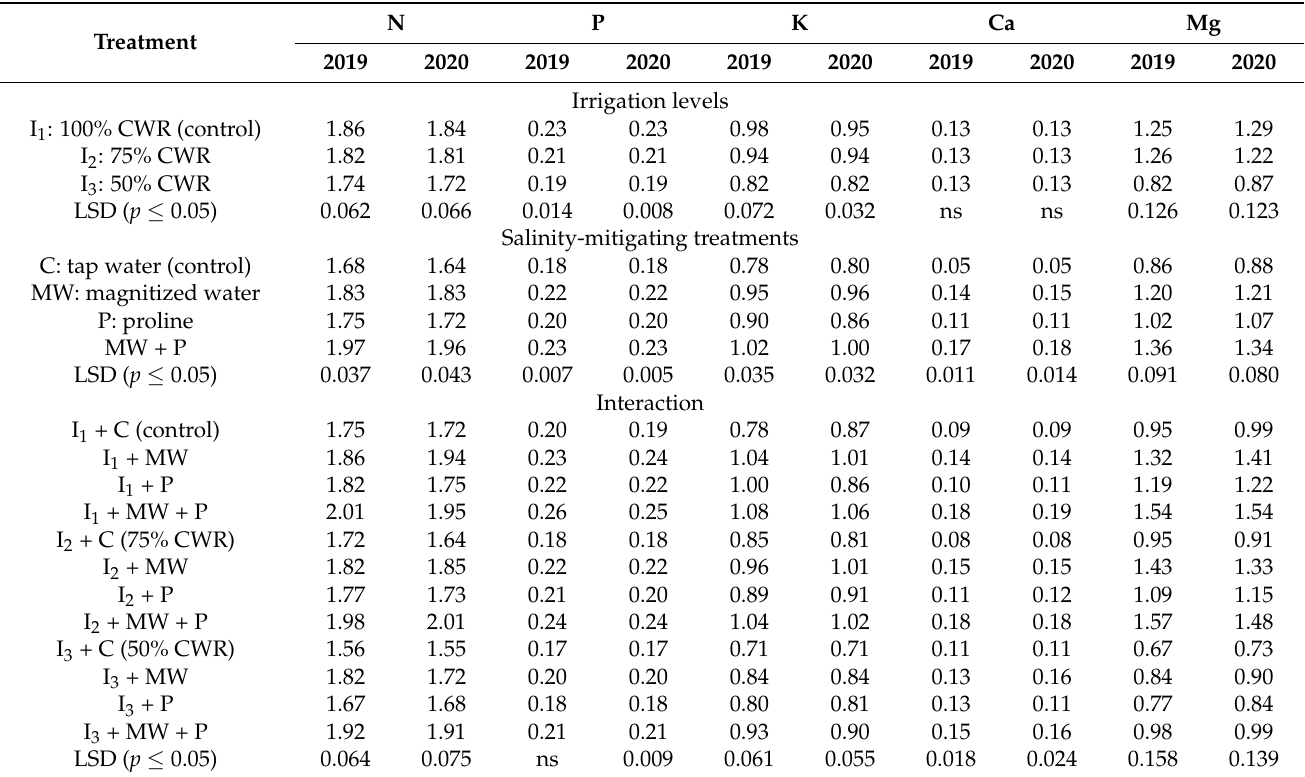
Table 4. Effect of MW, P, and MW + P on leaf macronutrient contents (%) of “Taifi” pomegranate shrubs grown under different irrigation regimes (I 1 , I 2 , and I 3 ), based on CWR, during the 2019